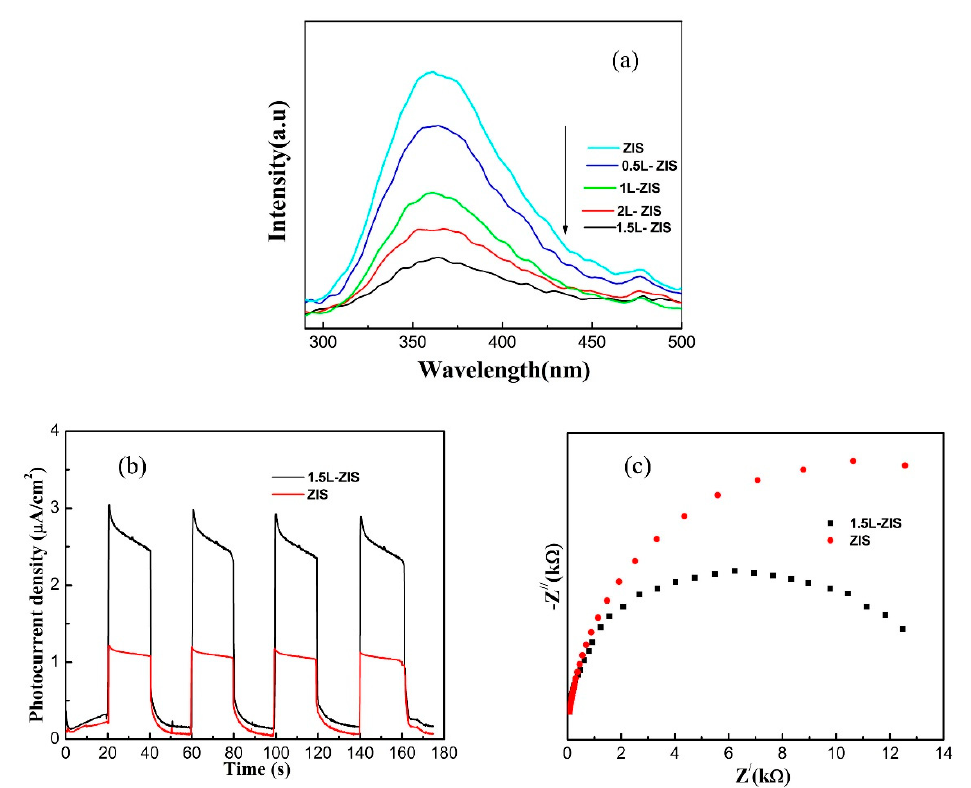
Figure 9. ( a ) Photoluminescence (PL) spectra of P-ZIS and doped ZIS samples; ( b ) transient photocurrents; ( c ) electrochemical impedance spectra of pristine ZIS and 1.5L-ZIS electrodes under visible light irradiation.